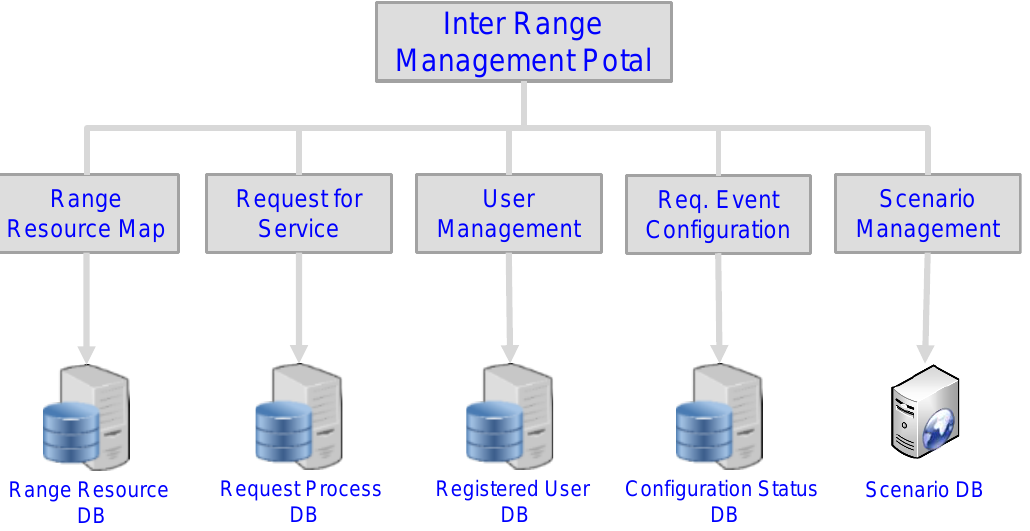
Figure 3. Multi-Cyber Range Management Function.